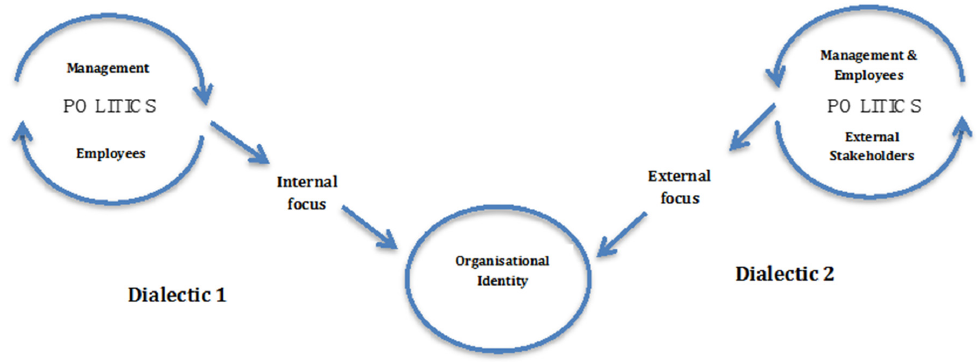
Figure 3. OI’s Political